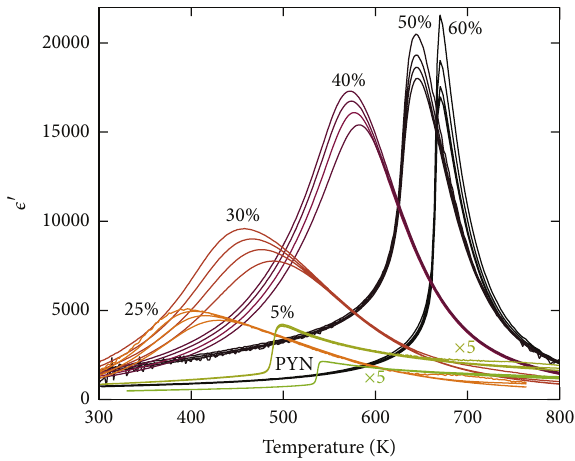
Figure 5: Real part of the dielectric constant ( 𝜖 󸀠 ) measured at 1kHz from RT to 530 ∘ C on PYN-PT ceramics exhibiting antiferroelectric (pure PYN and PYN-5% PT), relaxor (for 25, 30, and 40% PbTiO 3 content), or ferroelectric (50 and 60% PbTiO 3 content) behaviors. All samples were sintered between 950 ∘ C and 1050 ∘ C.